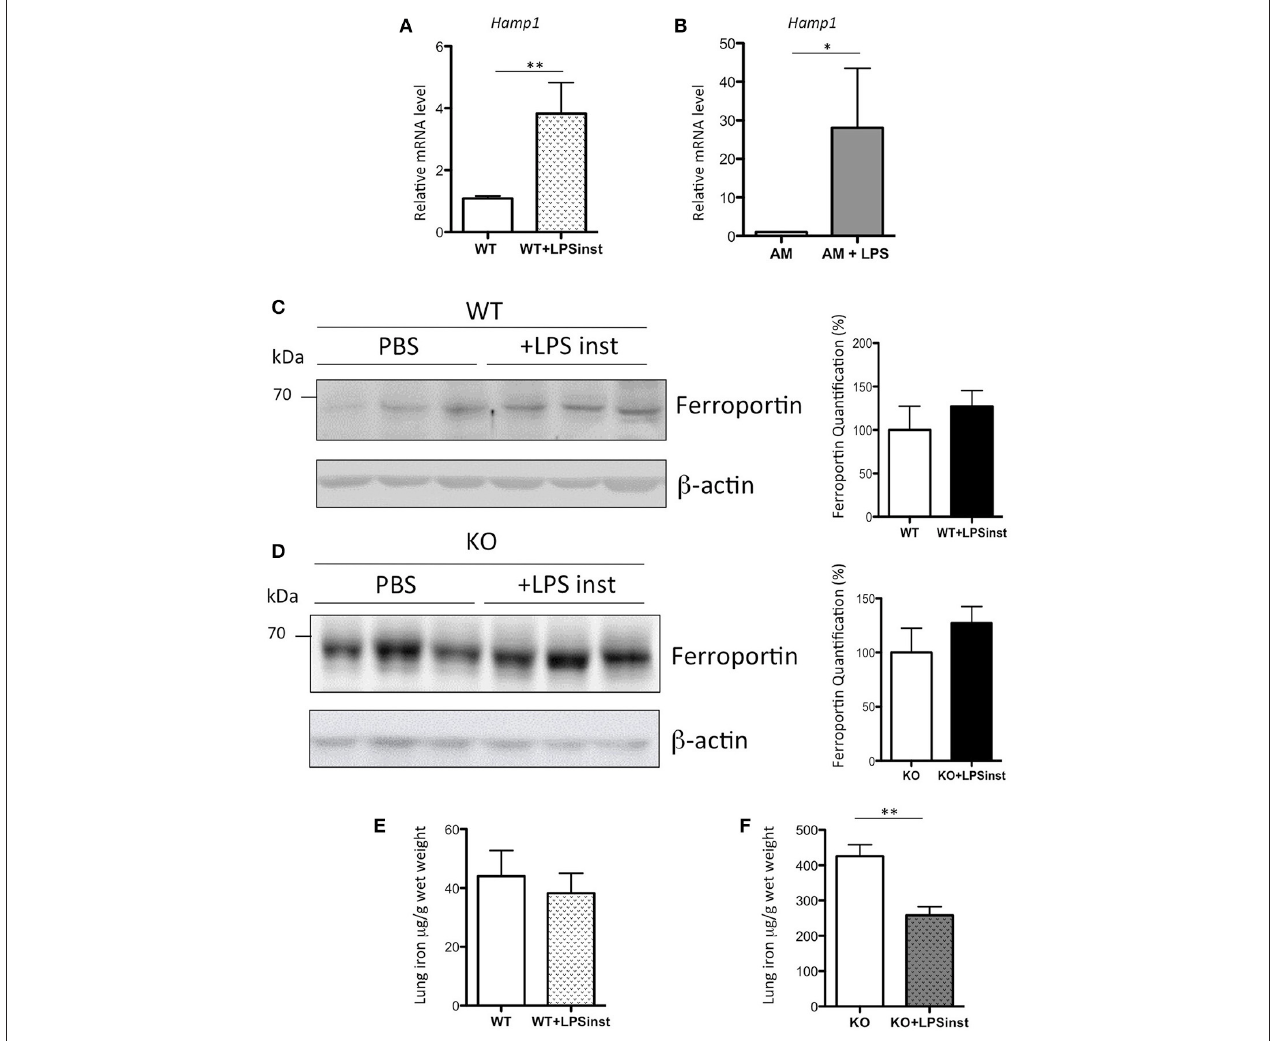
FIGURE 7 | Hepcidin, ferroportin, and iron responses after intranasal LPS instillation in WT and Hepc KO mice: Hamp , relative to Ppia , analyzed by real-time PCR, in the lung of mice given intranasal LPS infusion for 5h (A) and in purified AM treated for 6h with LPS (B) . Changes are expressed relative to PBS treated mice or untreated AM, respectively. Error bars represent SEM for n = 3–5 mice in each group. Statistical significance is indicated by asterisks (* p < 0.05, ** p < 0.01). Ferroportin protein levels analyzed by WB using proteins from membrane enriched-fractions isolated from the lung of WT (C) or Hepc KO mice (D) given intranasal LPS infusion for 5h. Quantifications of the blots are presented in % (100% set for WT and KO mice infused with PBS, respectively). Lung iron content in the lung of WT (E) or Hepc KO mice (F) given intranasal LPS infusion for 5h. Statistical significance is indicated by asterisks (** p <